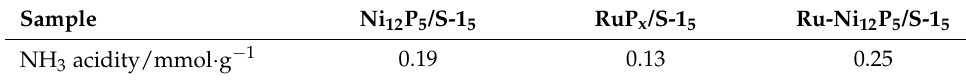
Figure 5. NH 3 -TPD profiles of the catalysts. Table 1. Acid sites analysis by NH 3 -TPD.